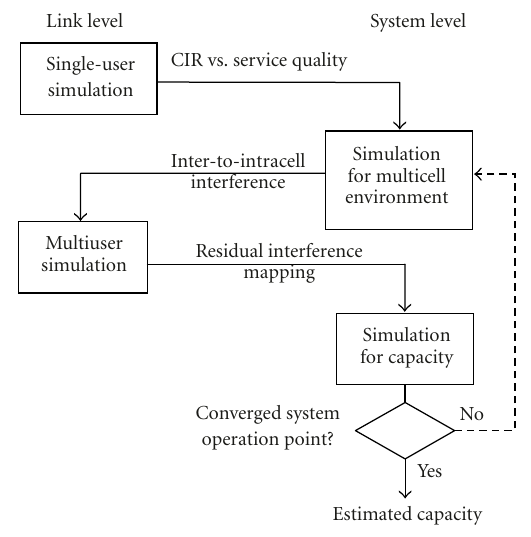
Figure 5: Workflow for PIC system